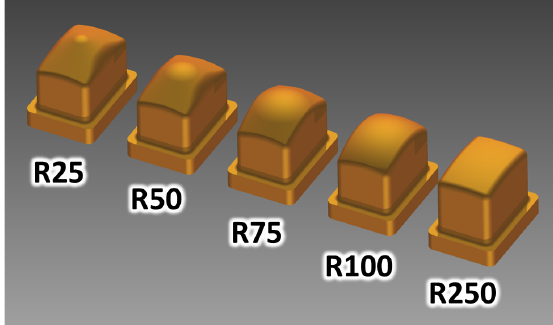
Figure 8. Punches used in the deep-drawing process to vary the forming loads. Double-curvature radius of 250mm (R250) causes the lowest load in the deep-drawing